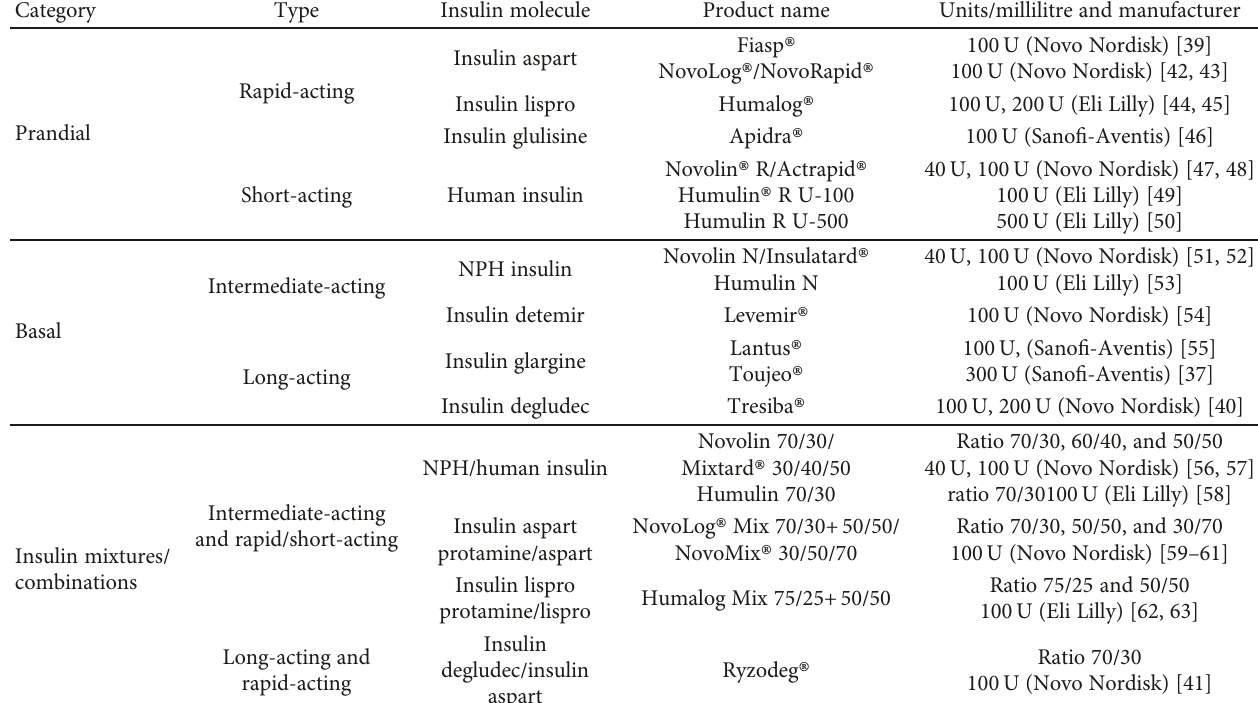
Table 1: An overview of the insulin categories, types, and available